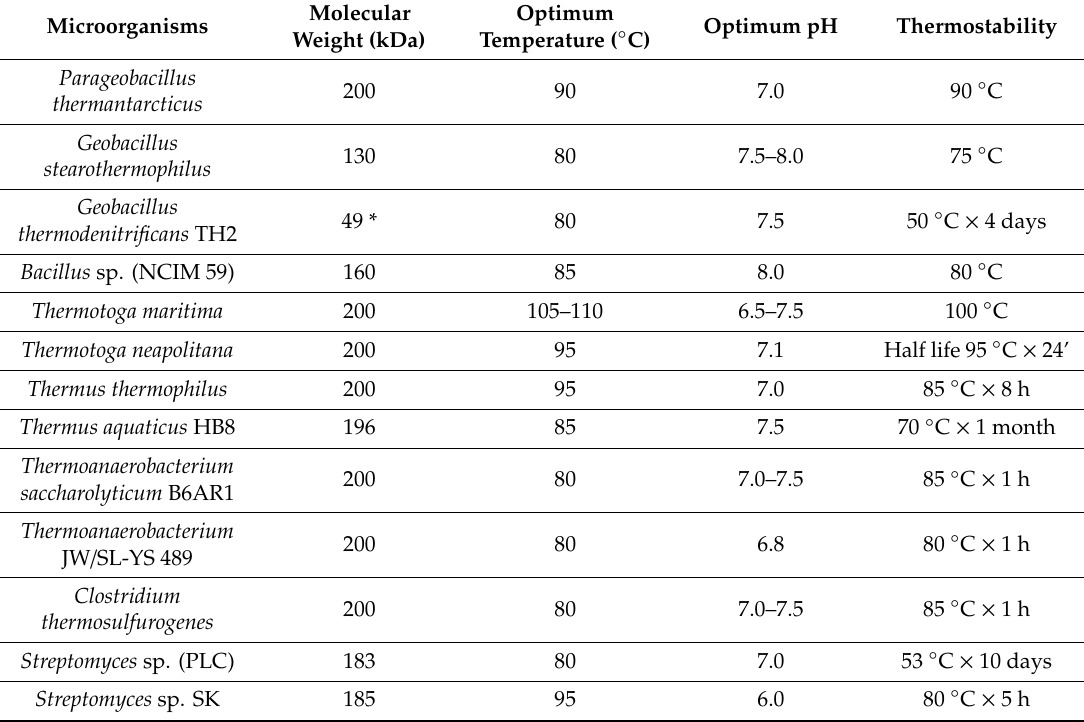
Table 1. Physical-chemical properties of xylose / glucose isomerases from thermophilic microorganisms.